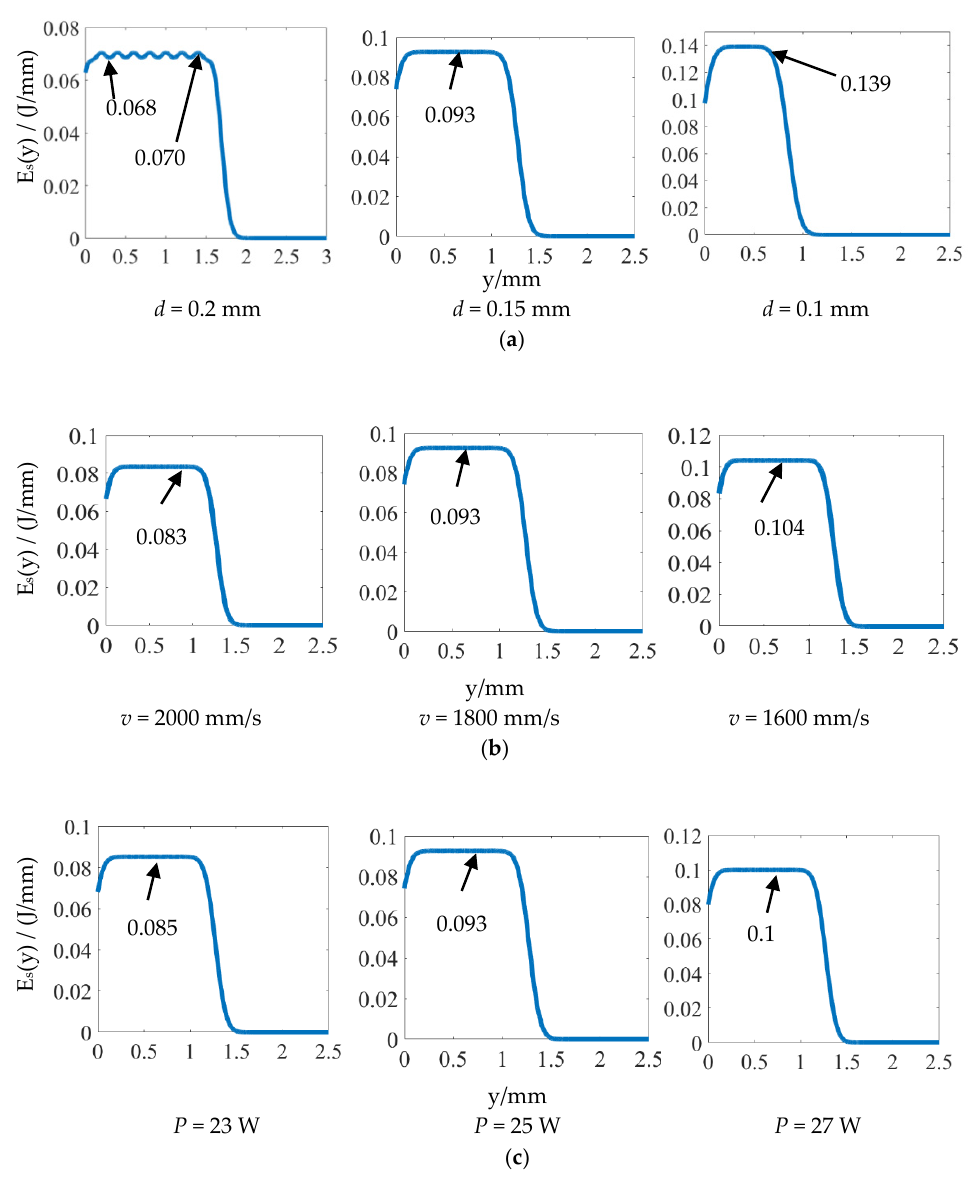
Figure 4. The effects of process parameters on the distribution of laser energy ( E s ( y ), J/mm): ( a ) scan spacing ( d ) is variable, P = 25 W, v = 1800 mm/s; ( b ) scan speed ( v ) is variable, P = 25 W, d = 0.15 mm; ( c ) laser power ( P ) is variable, v = 1800 mm/s, d = 0.15 mm.